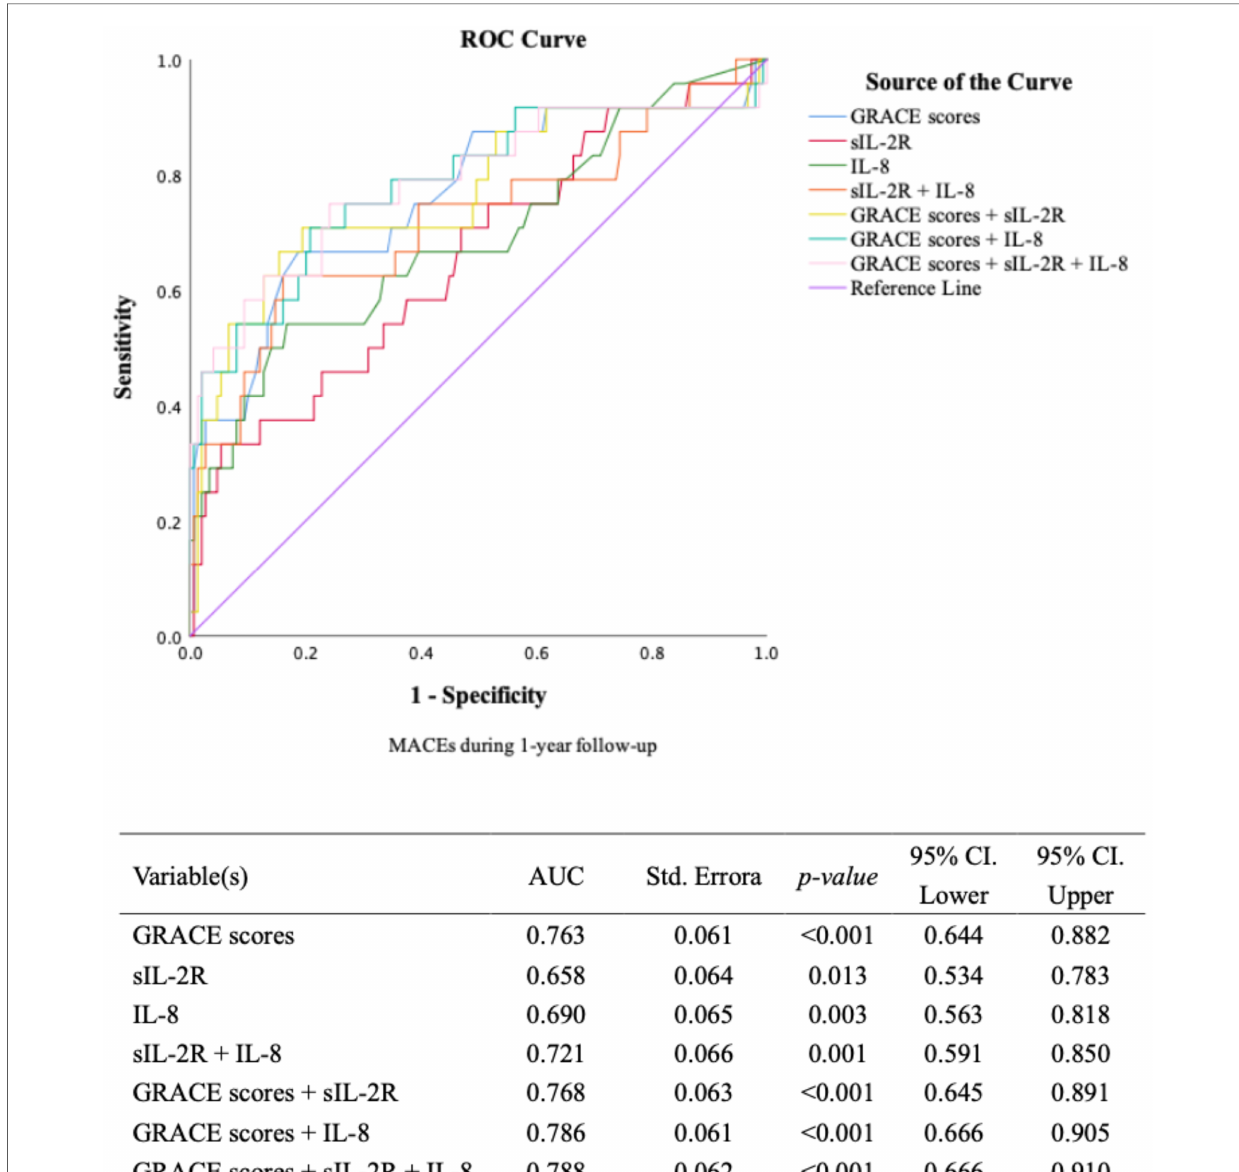
FIGURE 4 ROC curves for discriminating between patients with or without MACEs (IL, GRACE). ROC curves for discriminating between patients with or without MACEs during 1-year follow-up according to different